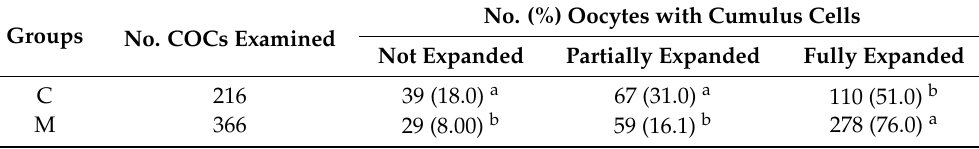
Table 2. Effect of melatonin on cumulus cells expansion.